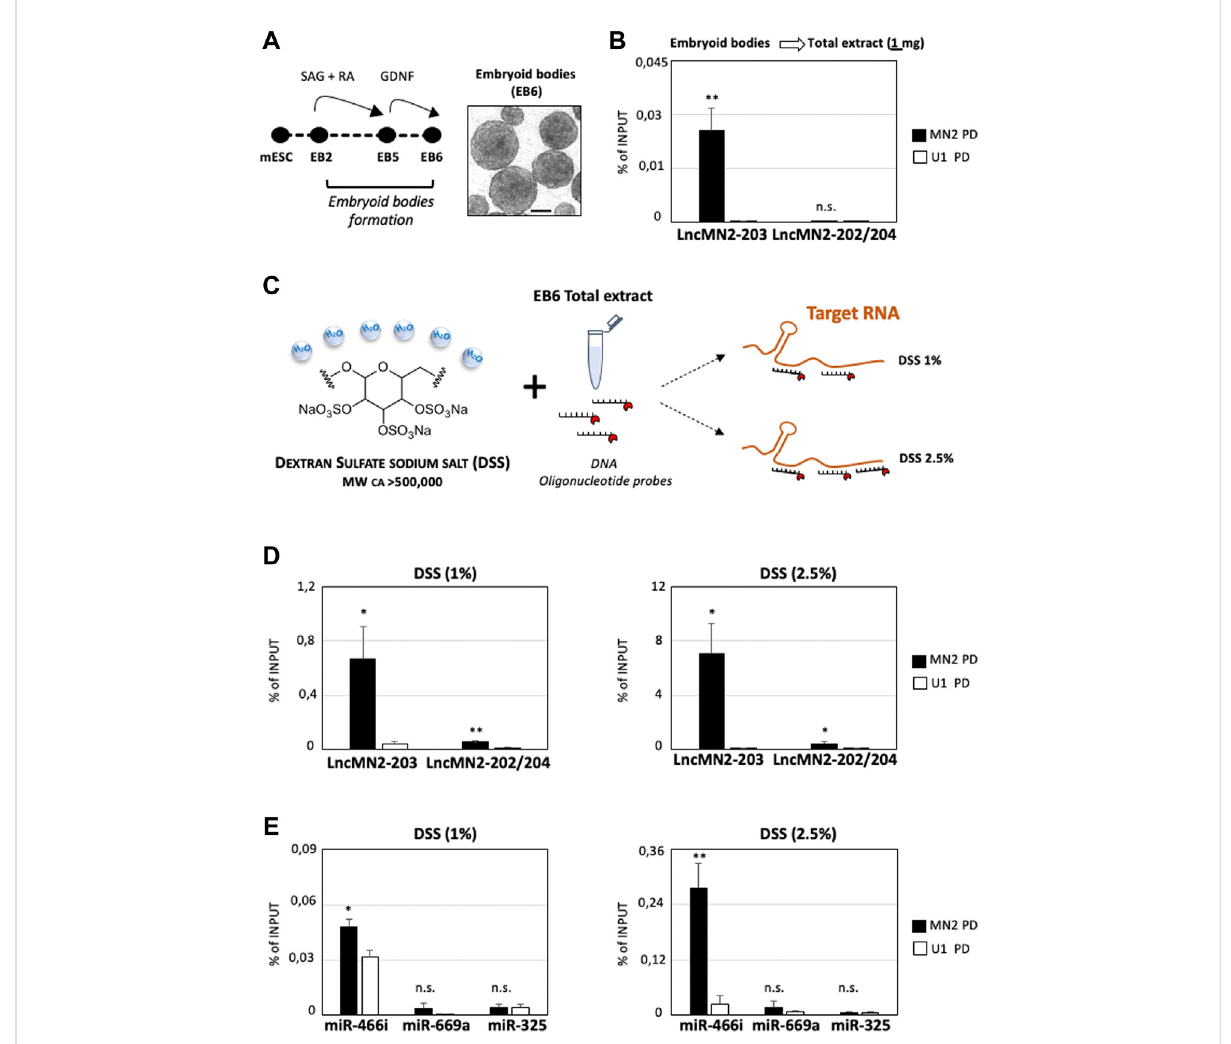
FIGURE 2 Dextran Sulfate Sodium salt increases the enrichment of LncMn2-203 and its miRNA interactor. (A) Left: Schematic representation of mESC- derived embryoid bodies differentiation (Capauto et al., 2018; D ’ Ambra et al., 2021). A representative fi eld of EBs at day 6 of differentiation (EB6) is shown aside. Scale bar: 100 μ m. SAG = Smoothened Agonist; RA = Retinoic Acid; GDNF = Glial cell line-derived neurotrophic factor. (B) Quanti fi cation by qRT-PCR of lncMN2-203 and lncMN2-202/204 recovery from lncMN2-203 (MN2) or control (U1 snRNA) pull-down experiments. A total of 1 mg of cell extracts prepared from differentiated EB6 were used for each reaction. LncRNA enrichments are expressed as Input percentage (%). Error bars represent SEM. n = 3 biological replicates. (C) Scheme of the Dextran Sulfate sodium salt (DSS) chemical structure and hygroscopic properties. By sequestering H20 molecules, the DSS salt increases the local concentration of DNA antisense probes targeting nucleic acid. (D) Quanti fi cation by qRT-PCR of lncMN2-203 and lncMN2-202/204 recoveries from lncMN2-203 (MN2) or control (U1 snRNA) RNA pull-down experiments. Different doses of DSS, 1% (Left) or 2.5% (Right), were used for each reaction. LncRNA enrichments are expressed as Input percentage (%). Error bars represent SEM. n = 3 biological replicates. (E) Quanti fi cation by qRT-PCR of miR-466i-5p, miR-669a-5p and miR-325-3p recoveries from lncMN2-203 (MN2) or control (U1 snRNA) RNA pull-down experiments. Different doses of DSS, 1% (Left) or 2.5% (Right), were used for each reaction. MiRNAenrichmentsare expressed as Input percentage (%).Error barsrepresent SEM. n = 3biologicalreplicates. Data